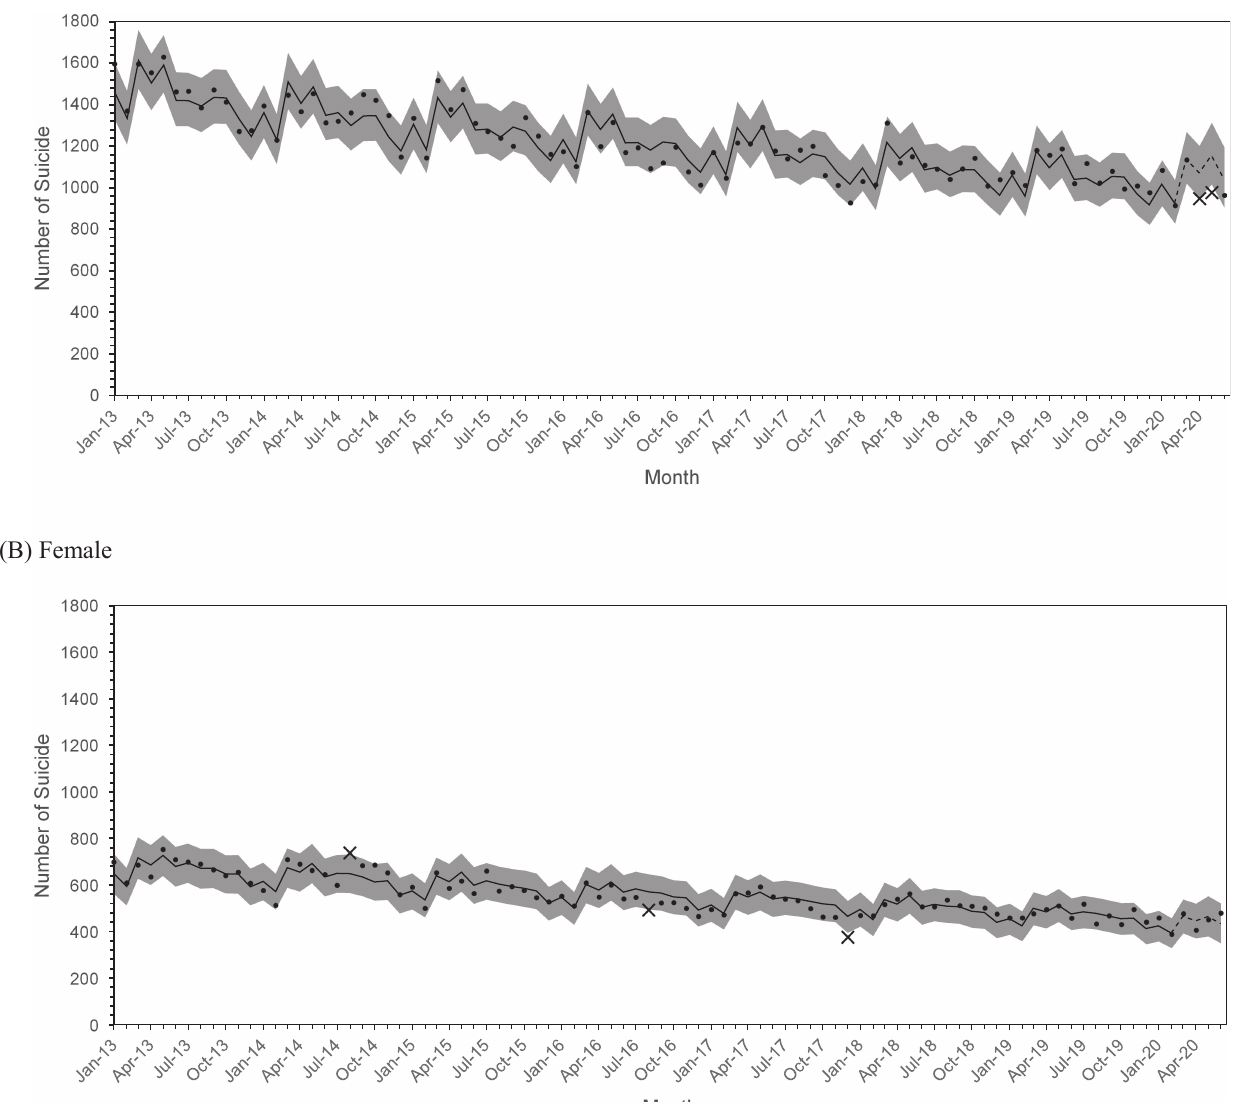
Figure 1. Monthly number of suicides and 95% prediction interval by sex, (A) male and (B) female. Dots: observed number of suicides within the 95% prediction interval; ' : observed number of suicides outside the 95% prediction interval; Solid line: predicted number of suicides in non-pandemic periods; Dashed line: predicted number of suicides in pandemic periods; Gray strip: 95% prediction interval for the number of suicides based on the simulated